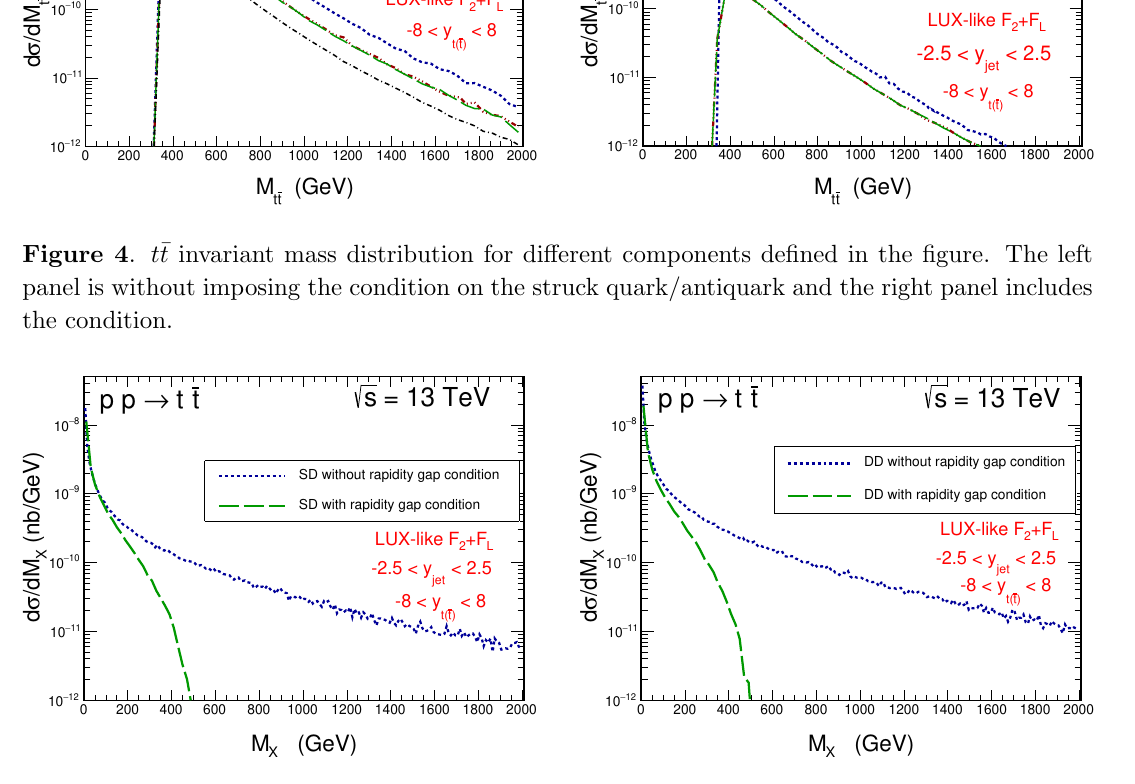
Figure 5 . Distribution in the mass of the dissociated system for single dissociation (left) and double dissociation (right). We show result without and with the rapidity gap